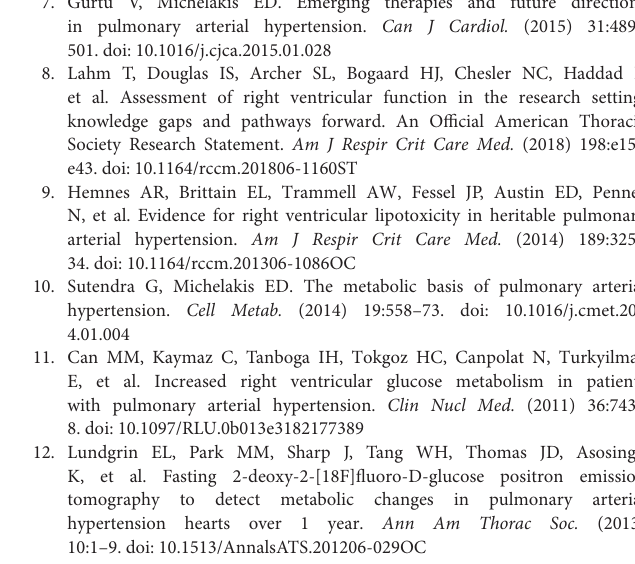
Supplementary Figure 1 | Overview of the experimental design. Rats were injected with SU5416 (Sugen) or control DMSO and placed into hypoxia for 3 weeks. For the treatment group (SuHx + ACTZ); acetazolamide (ACTZ) was added to the drinking water on day 7. Supplementary Figure 2 | Principal component analysis (PCA) between SuHx and control groups. Supplementary Figure 3 | Heatmap across all samples of the significantly changed transcripts (FDR < 0.05) involved in fatty acid oxidation. Featured scaling applied on normalized counts for presentation of the data. n = 5 individual animals in each group. Supplementary Figure 4 | Pulmonary Artery Acceleration Time (PAAT) quantitative data ( n = 5–14 animals per group). Experimental groups: Control, SuHx, and SuHx + ACTZ. Statistical analysis by one-way ANOVA and Tukey’s post-hoc test. Error bars are mean ± SEM ( ∗ P < 0.05, ∗∗ P < 0.01, and ns, non-significant). Supplementary Figure 5 | Treatment with ACTZ does not alter left ventricular performance and remodeling. (A) Ejection fraction. (B) Fractional shortening (FC). (C) Cardiac output (CO). (D) Left ventricular (LV) end diastolic volume. (E) Posterior wall thickness in diastole. (F) Anterior wall thickness in diastole. Quantitative data from 5 to 9 animals per group. Experimental groups: Control, SuHx, and SuHx + ACTZ. Statistical analysis by one-way ANOVA and Tukey’s post-hoc test. Error bars are mean ± SEM. Supplementary Figure 6 | Effects of ACTZ treatment on LV metabolism associated markers in SuHx animals. (A) Fatty acid transport and oxidation transcripts. (B) Glucose uptake and tricarboxylic acid cycle (TCA) enzymes. (C) Mitochondrial transcription factors ( n = 7–8 per group). Experimental groups: Control, SuHx, and SuHx + ACTZ. Statistical analysis by one-way ANOVA and Tukey’s post-hoc test. Error bars are mean ± SEM ( ∗ P < 0.05 compared to control, # P < 0.05 compared to SuHx). Supplementary Table 1 | Primers for rat genes in quantitative real-time